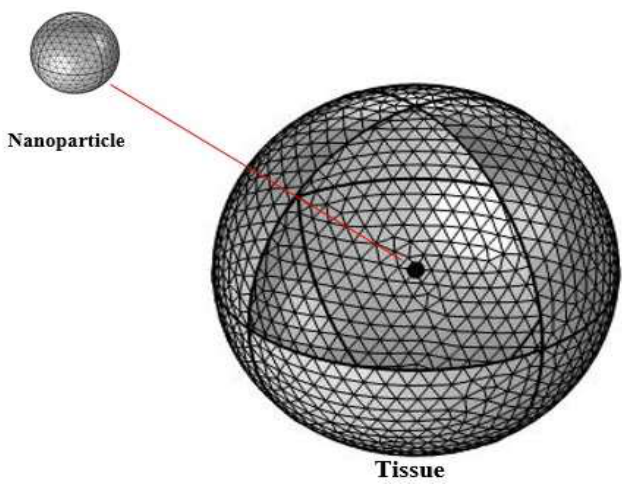
Figure 3. The discretized geometry of tissue and nanoparticle.